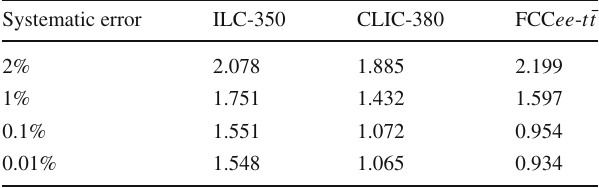
Table 5 95% CL upper bounds for | a NP τ | expected from the t ¯ t mode of various future e − e + colliders Systematic error